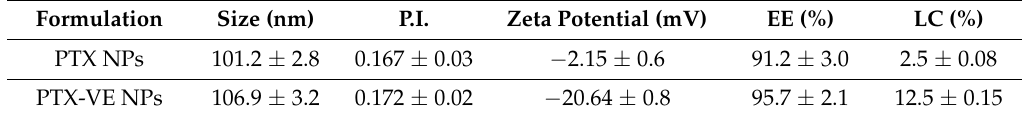
Table 1. Physicochemical characteristics of PTX NPs and PTX-VE NPs (n = 3).